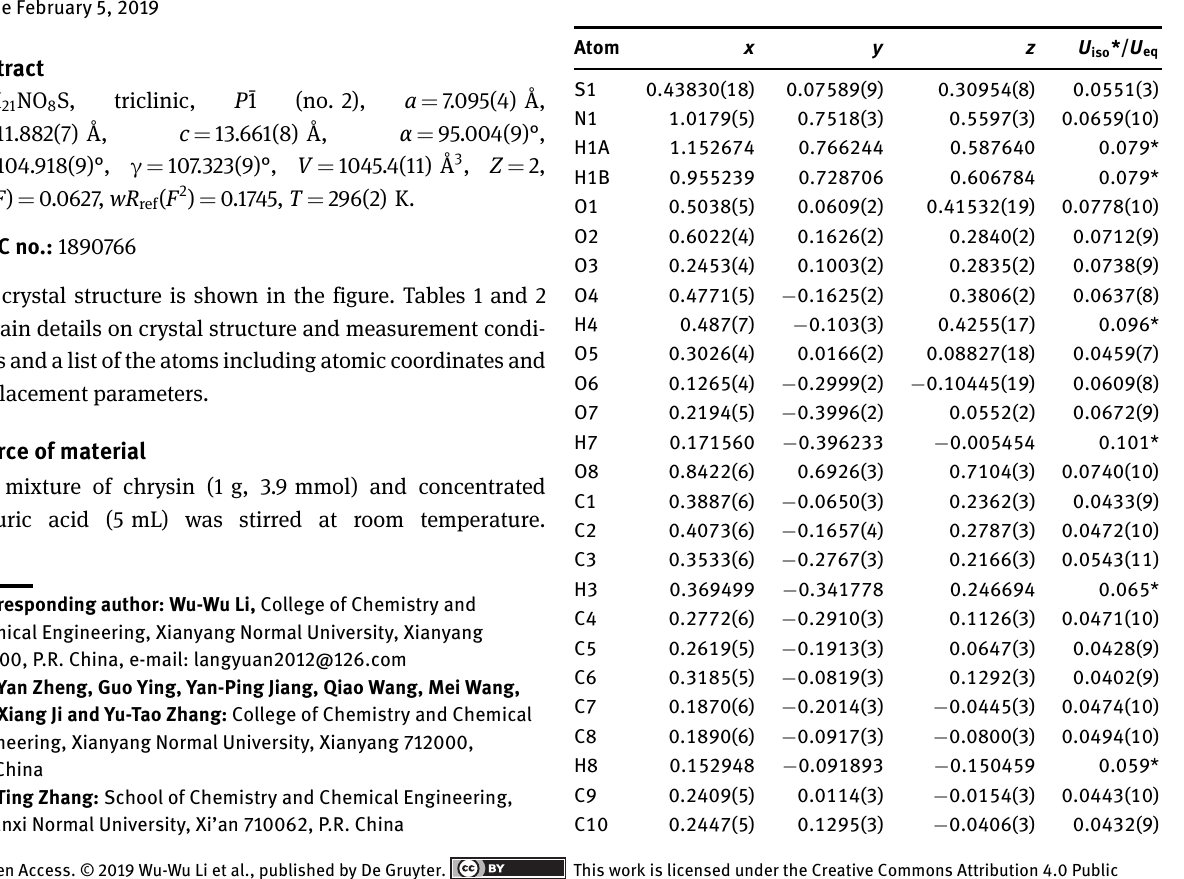
Table 2: Fractional atomic coordinates and isotropic or equivalent isotropic displacement parameters (Å 2